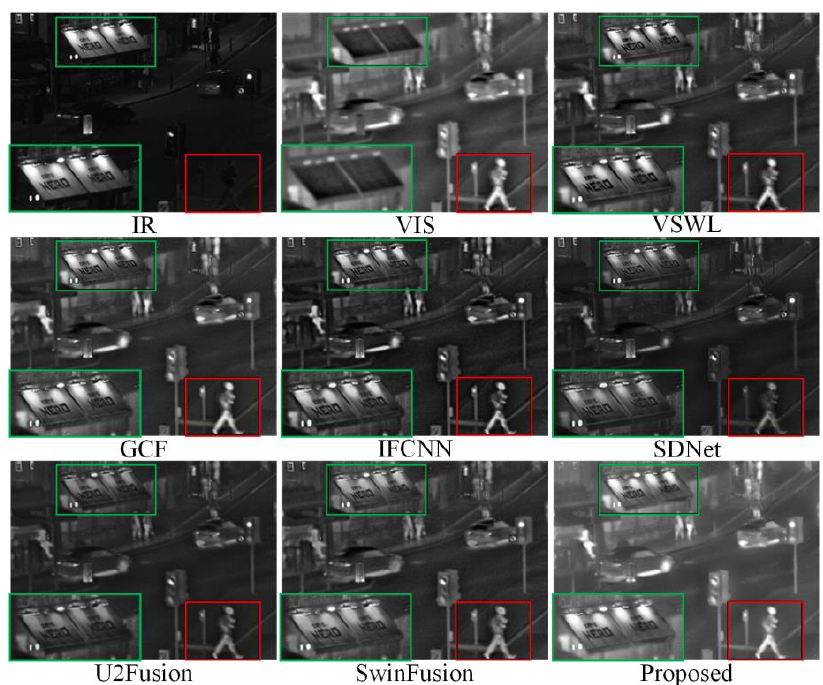
Figure 9. Comparison of performance of various methods on source images of Queens Road, Bristol. For a clear comparison, we select two same regions (i.e., the green and red boxes) in each image, and the green boxes are zoomed in the bottom left corner.